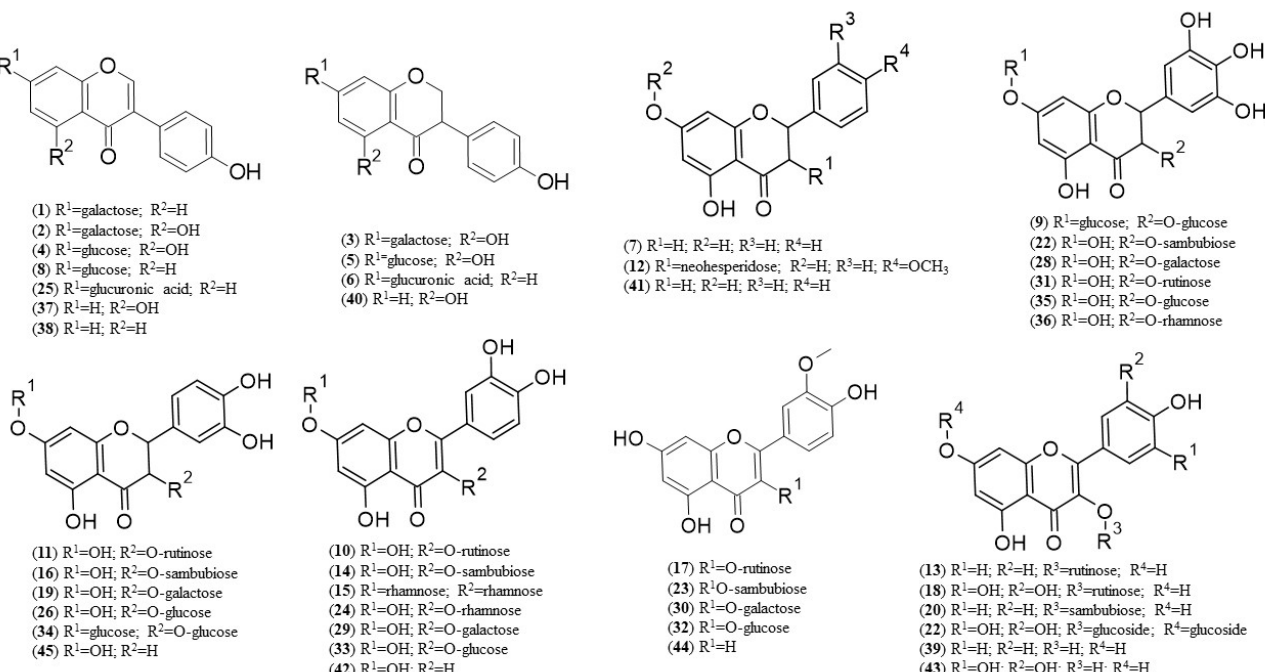
Figure 4. Chemical structure of polyphenolic compounds identified in Arabidopsis thaliana roots and shoots grown under GMF and NNMF conditions. Formulae numbers refer to the compounds cited in the main text and in Table 9.